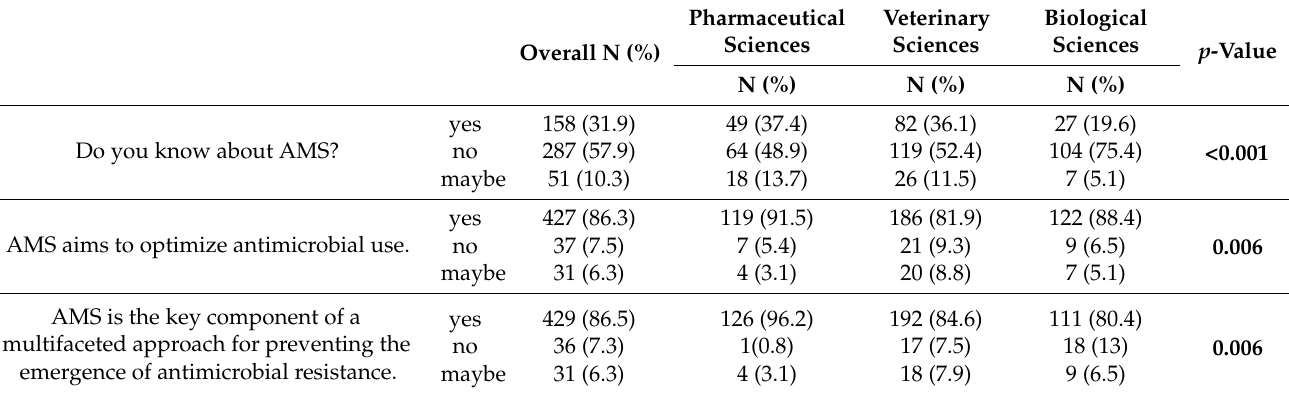
Table 4. Participant’s knowledge about antimicrobial stewardship